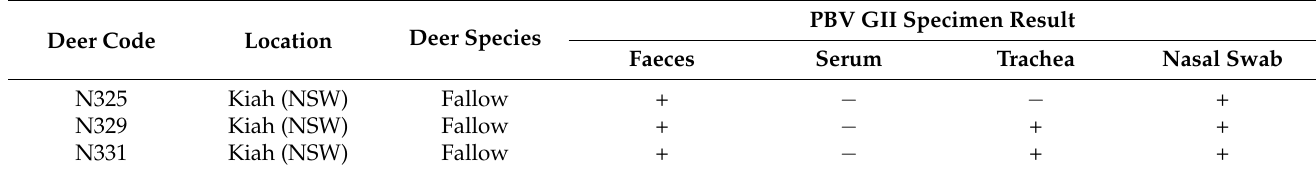
Table 5. Multi-specimen detection of PBV genogroup